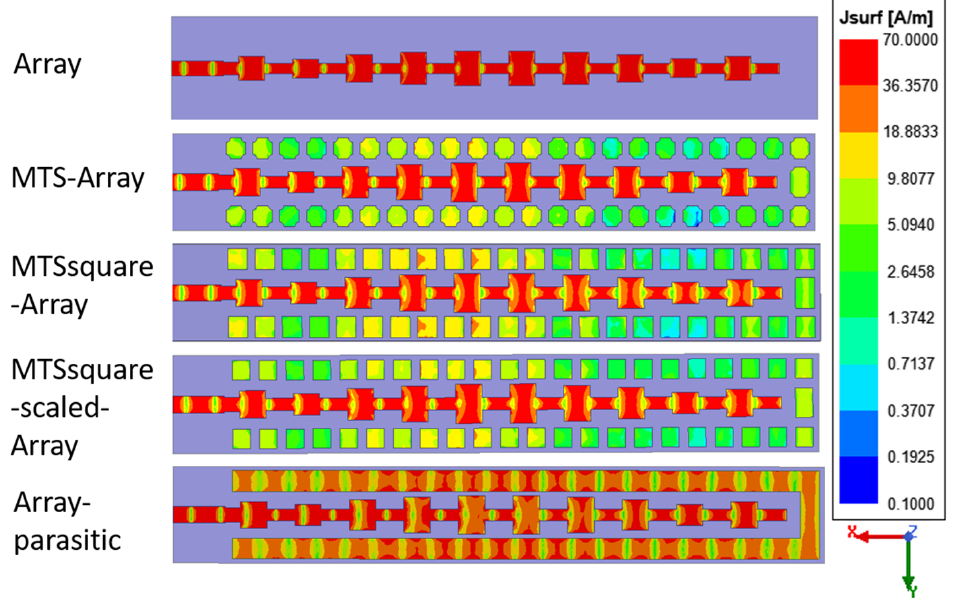
Figure 4. Surface current distribution at 24.15 GHz for the antennas under analysis.